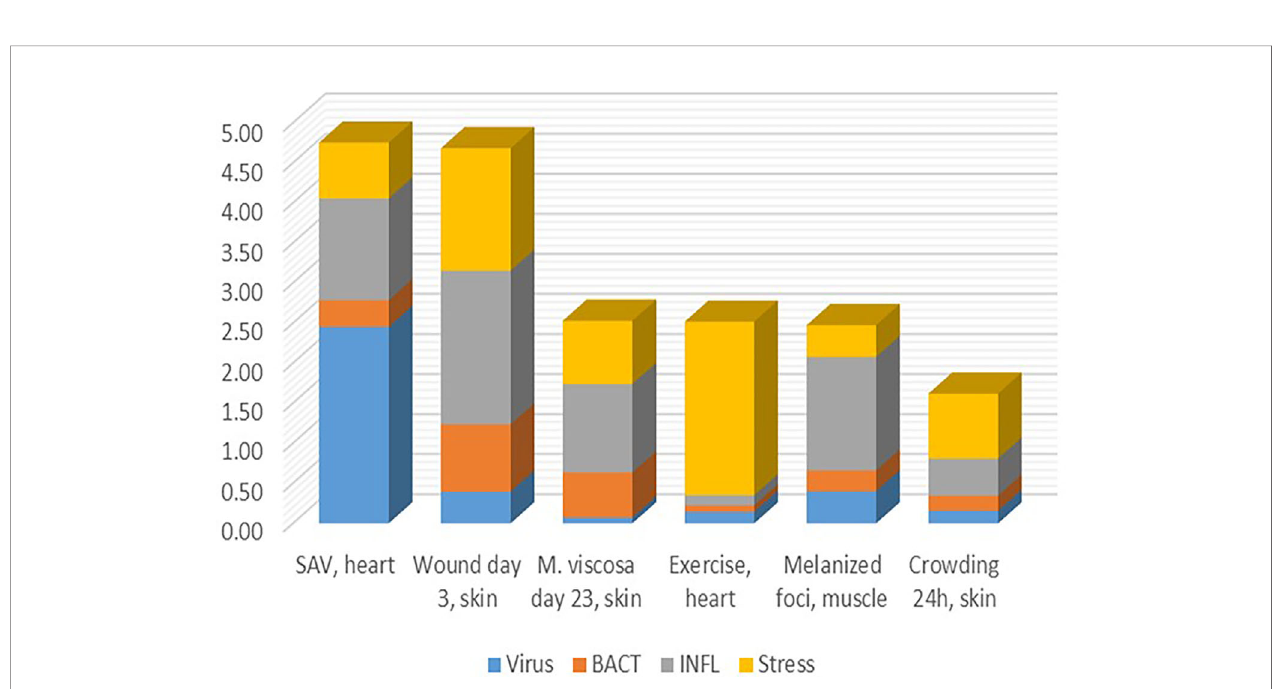
FIGURE 7 | Examples of transcriptome responses (contrast) with contribution of several TM shown as the mean log 2 -Expression Ratios.